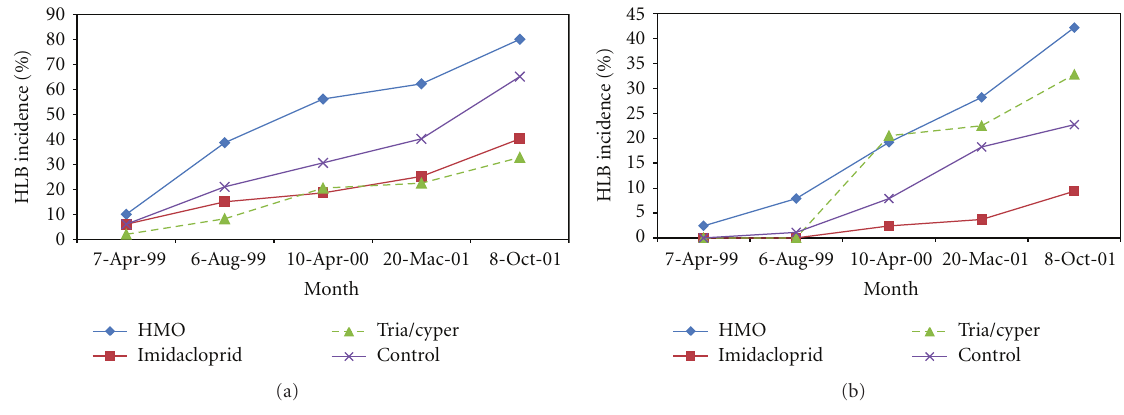
Figure 2: (a) Percentage of HLB-symptomatic infected trees on control and treated citrus orchard at Jemukan. (b) Percentage of HLB diseased trees on control and treated citrus orchard at Jemukan.